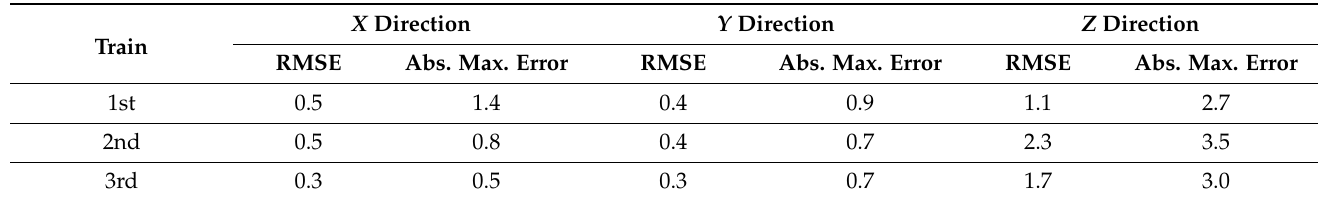
Table 3. Difference in displacement between the photogrammetry and the laser tracker (unit: mm).